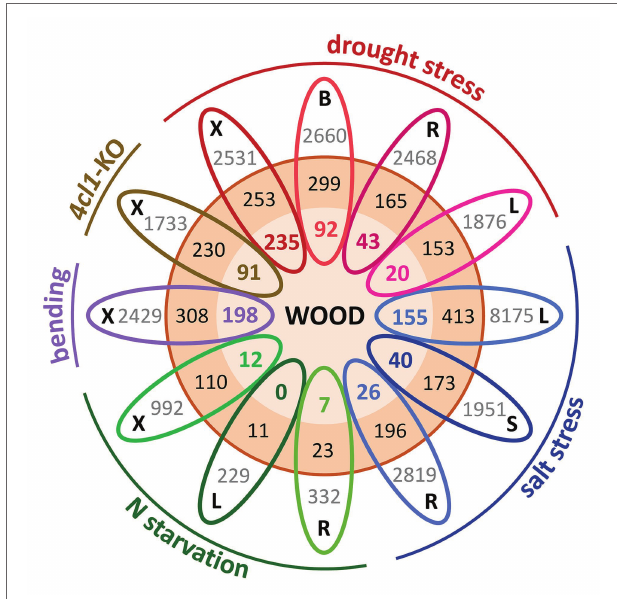
FIGURE 1 | Gene expression divergence in response to abiotic stress among Populus wood-expressed paralogs. Salicoid duplicates (3,428 genes or 1,714 paralogs pairs, orange circle) showing expression correlations of ≥ 0.75 across the secondary stem (Sundell et al., 2017) were interrogated for their responsiveness to different perturbations, including nitrogen (N) starvation in roots, leaves (Luo et al., 2015), and xylem (Lu et al., 2019), tension wood induction by bending (Swamy et al., 2015), drought-stressed xylem, bark, roots, and leaves (Xue et al., 2016), xylem of lignin-deficient trees (4CL1-KO; Tsai et al., 2020), and salt-stressed leaves, stem, and roots (Yao et al., 2020). Each oval represents one tissue (B, bark; L, leaf; R, root; S, stem; and X, xylem) from a given experiment, color- coded by perturbation type. Gray values indicate the total number of differentially expressed genes for the specific tissue-stress combination as reported in the source paper. Boldfaced color values (inner orange circle) indicate wood-expressed paralogous gene pairs where both members of the pair were differentially expressed in response to the indicated stress, whereas black values (outer orange circle) denote the number of cases where only one paralog of a pair showed differential expression. For clarity of illustration, each stress dataset was compared with the wood paralogs individually without considering overlapping gene responses across tissues or stress